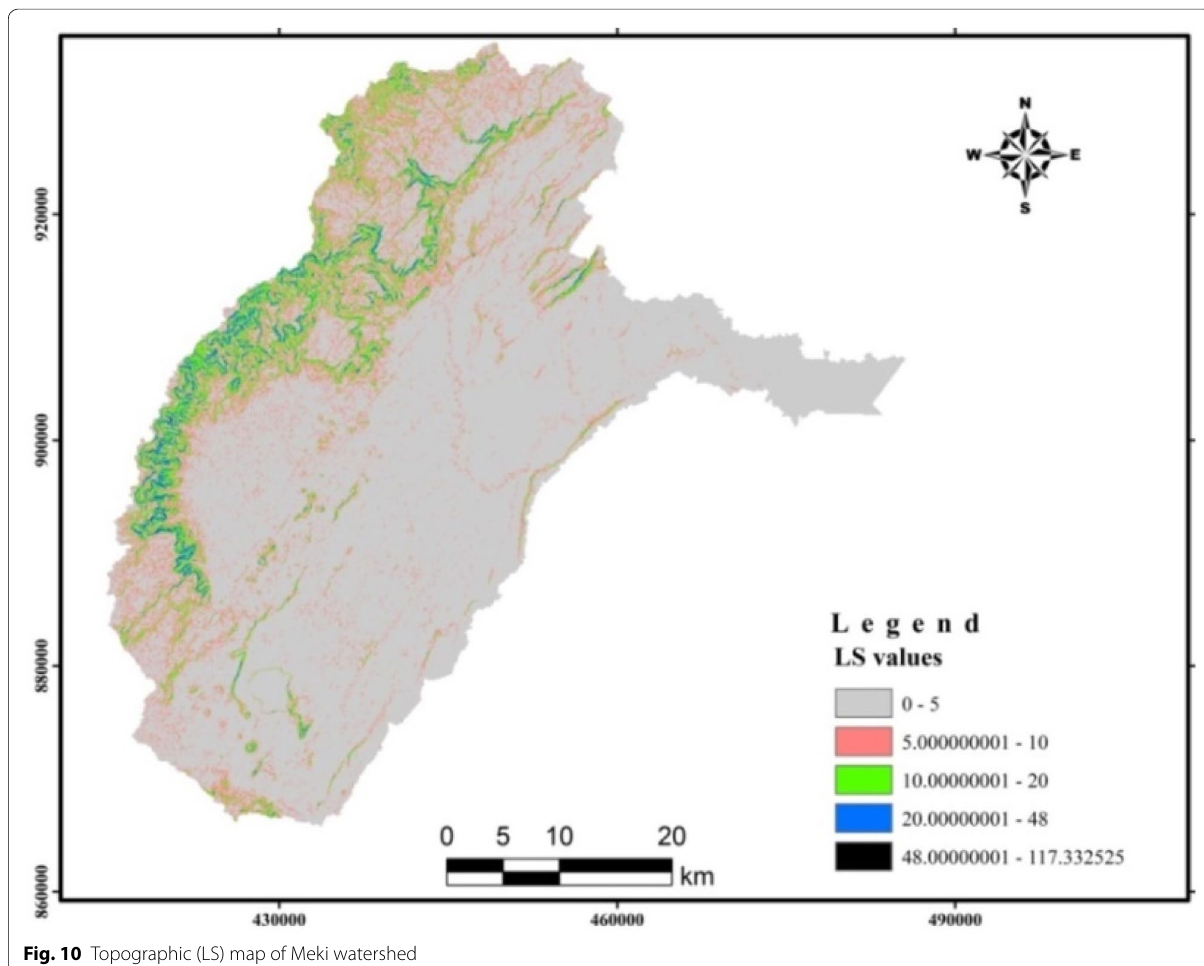
Fig. 10 Topographic (LS) map of Meki watershed